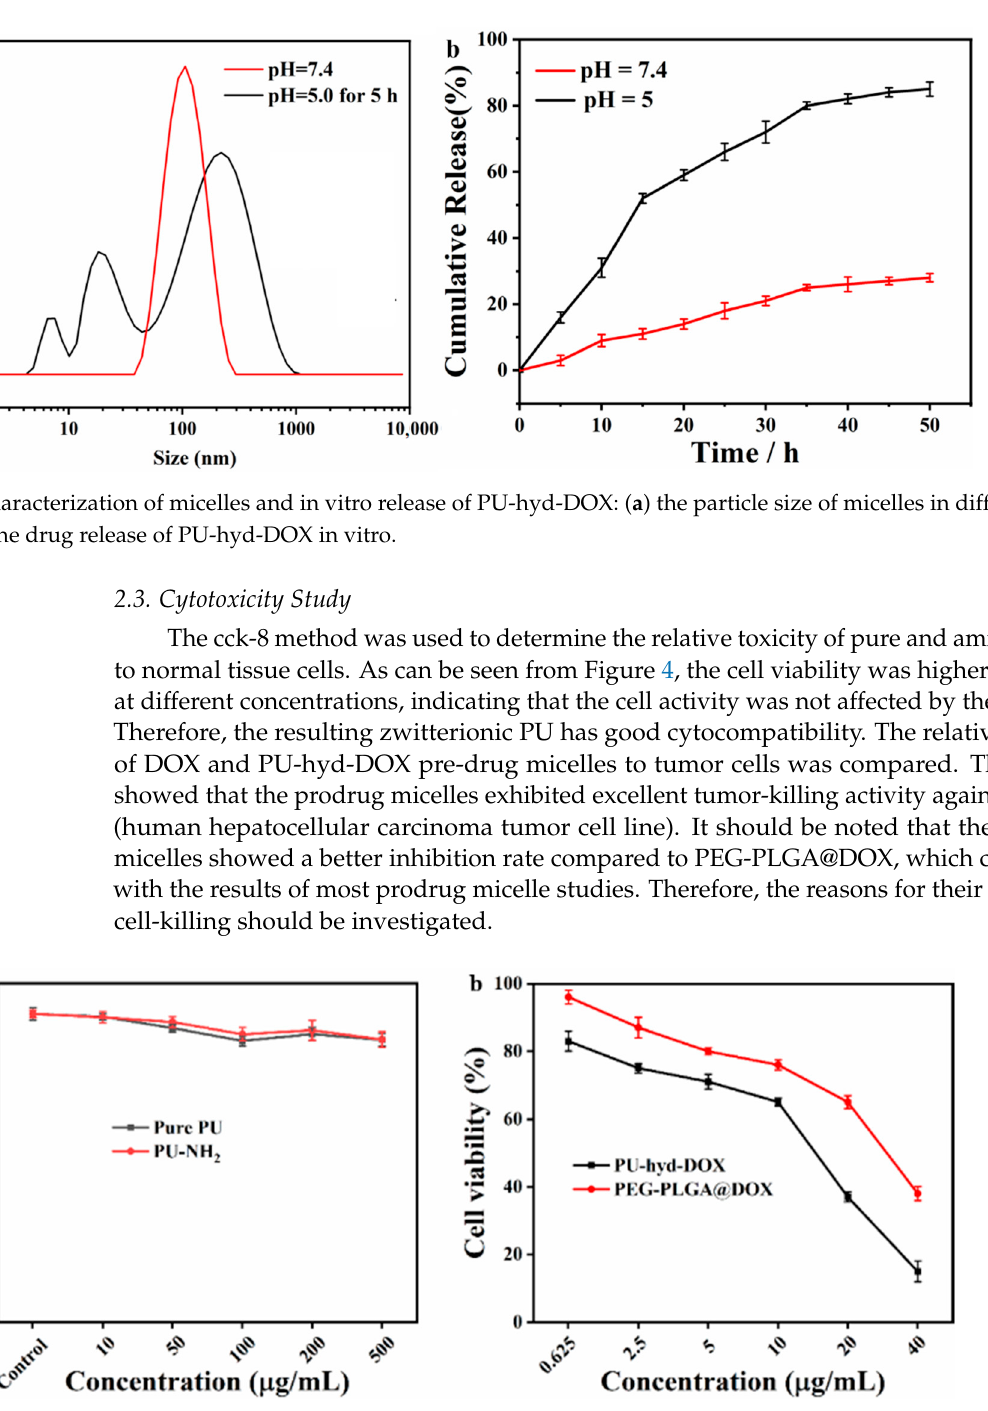
Figure 4. Cytotoxicity study of polymers and prodrug: ( a ) Pure PU and PU-NH 2 ; ( b ) PEG-PLGA@DOX and PU-hyd-DOX.